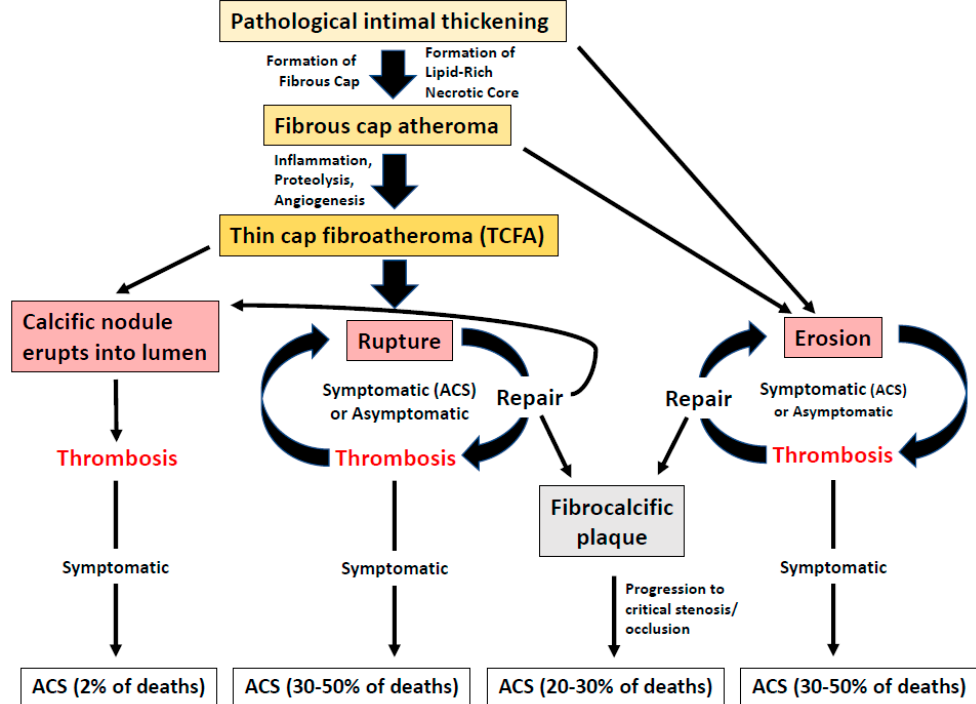
Figure 1. Key insights into plaque evolution and progression processes, and their clinical correlates.